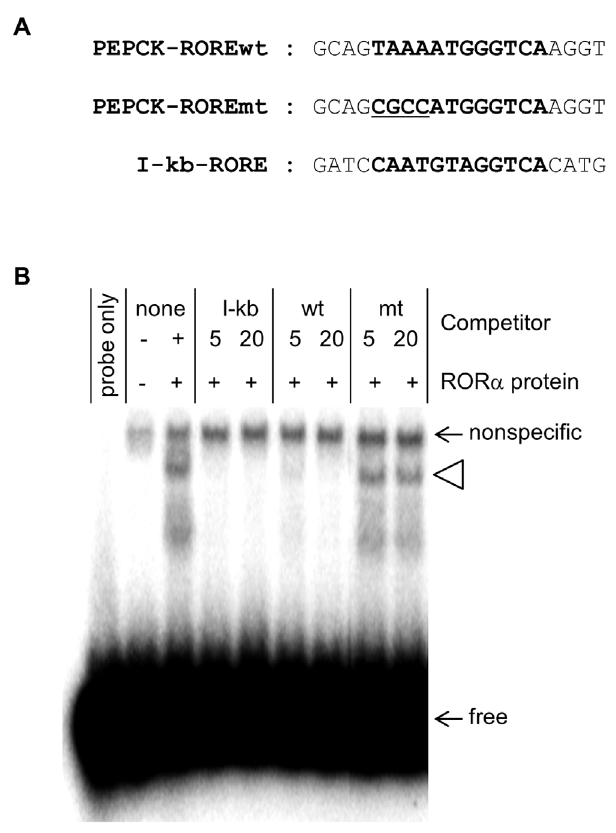
Fig 2. ROR α binds to a putative response element in PEPCK. (A) Sequence of the putative ROR α response element (in boldface) in human PEPCK. The probe mt is equivalent to this motif, except that underlined nucleotides have been mutated. The I-kb probe contains the known ROR α response element in NF-kappaB inhibitor α . (B) EMSA was used to test the ability of unlabeled wild type and mutated probes, at 5- and 20-fold excess, to inhibit binding of ROR α to the putative response element (open arrowhead). The positions of free probe (free) and nonspecific probe of ROR α for crude protein (nonspecific) were indicated. All reactions except lane 1 contain crude products from in vitro translation. In lane 2, the probe was incubated with the crude product obtained from in vitro translation in the absence of the ROR α expression vector.